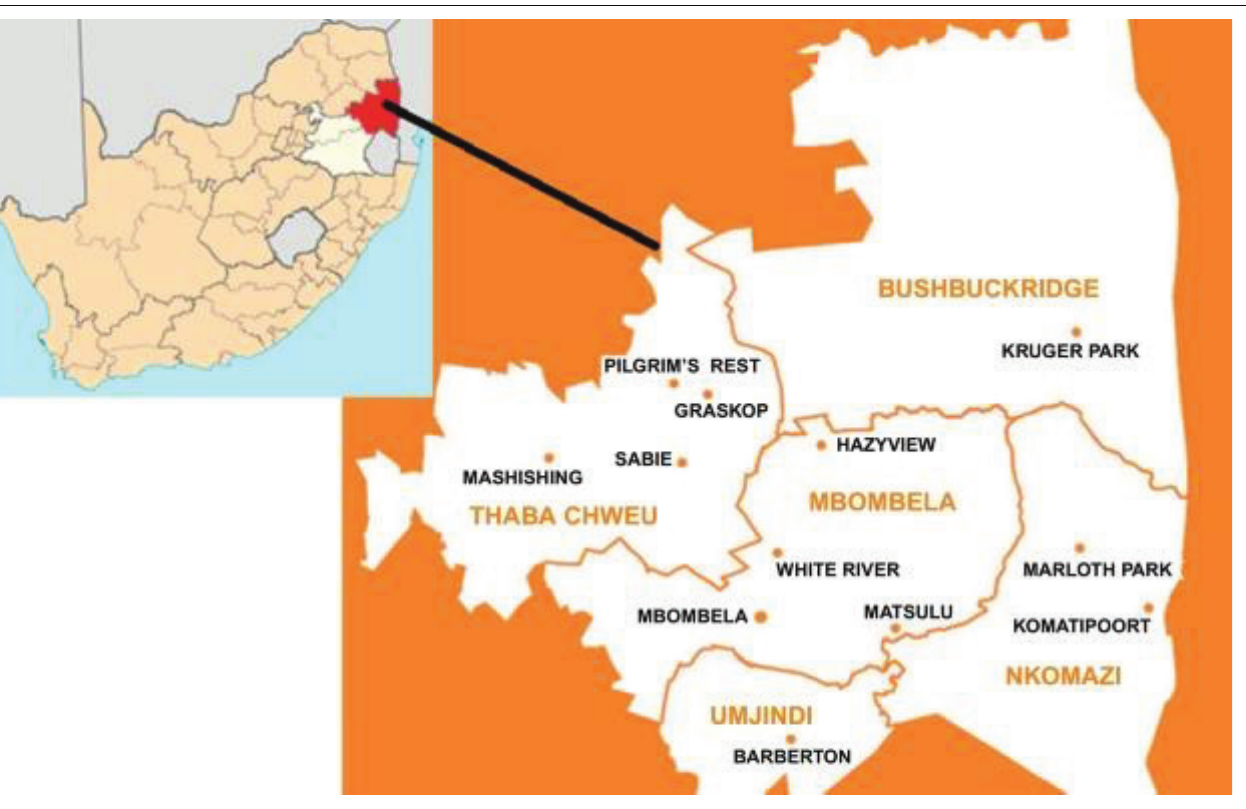
FIGURE 1: Ehlanzeni local municipalities map.